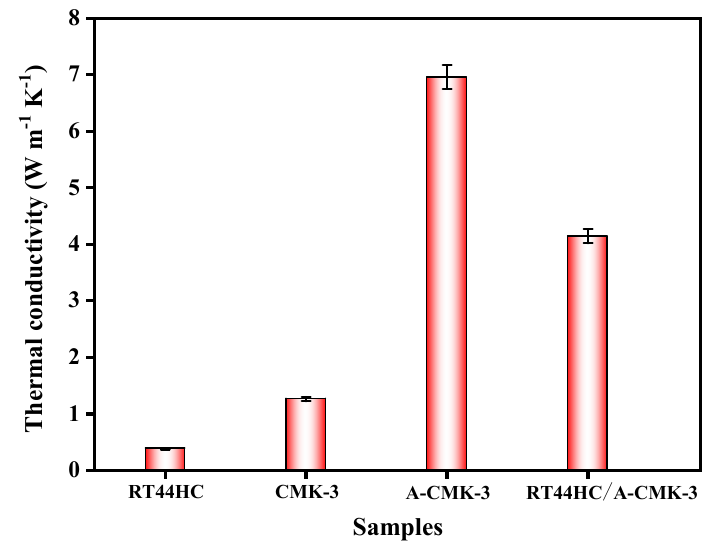
Figure 7. Thermal conductivity of A-CMK-3 based PCM.